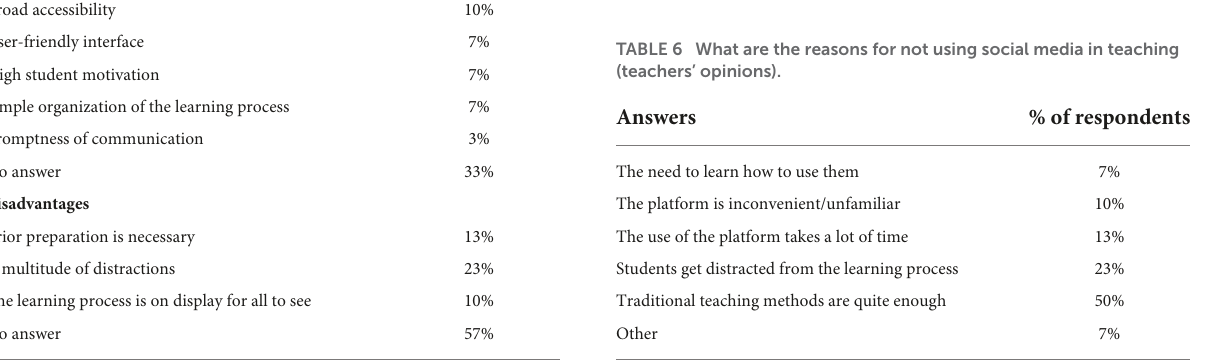
Low Average Sufficient High